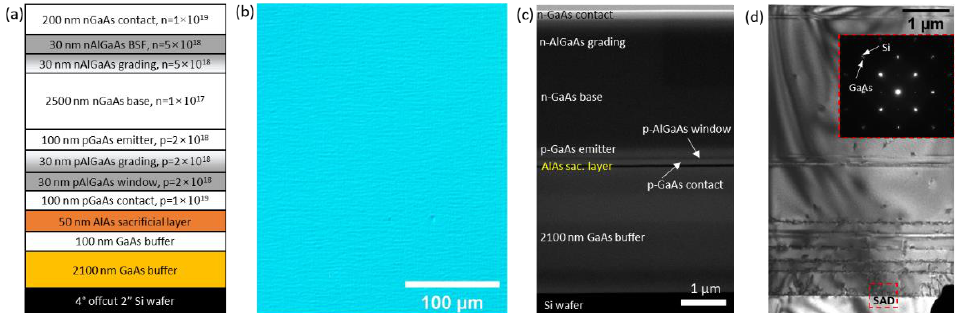
Figure 2. ( a ) Schematic illustration of GaAs one-junction solar cell grown on Si substrate. ( b ) Differential interference contrast optical microscopy image. ( c ) Cross-sectional SEM image of the entire solar cell structure. ( d ) Cross-sectional bright-field TEM image. Inset shows the selected area diffraction pattern.